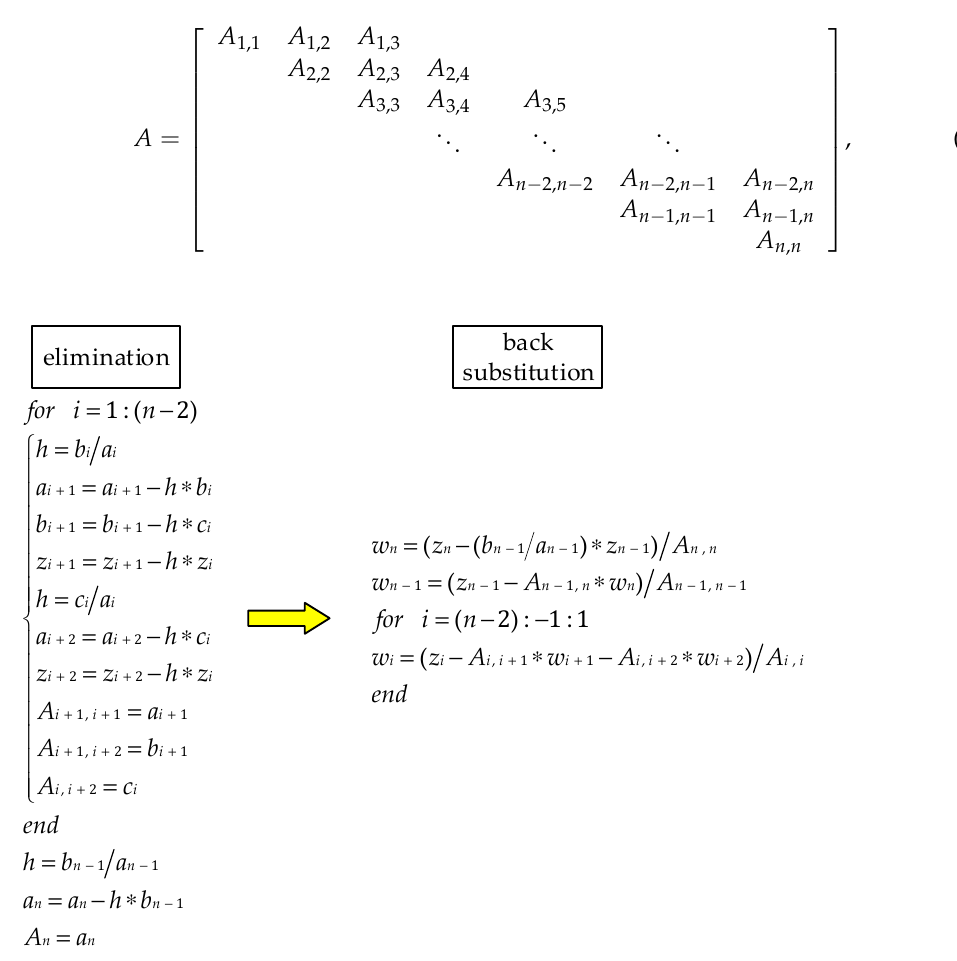
Figure 6. Flow chart of Gauss elimination method.